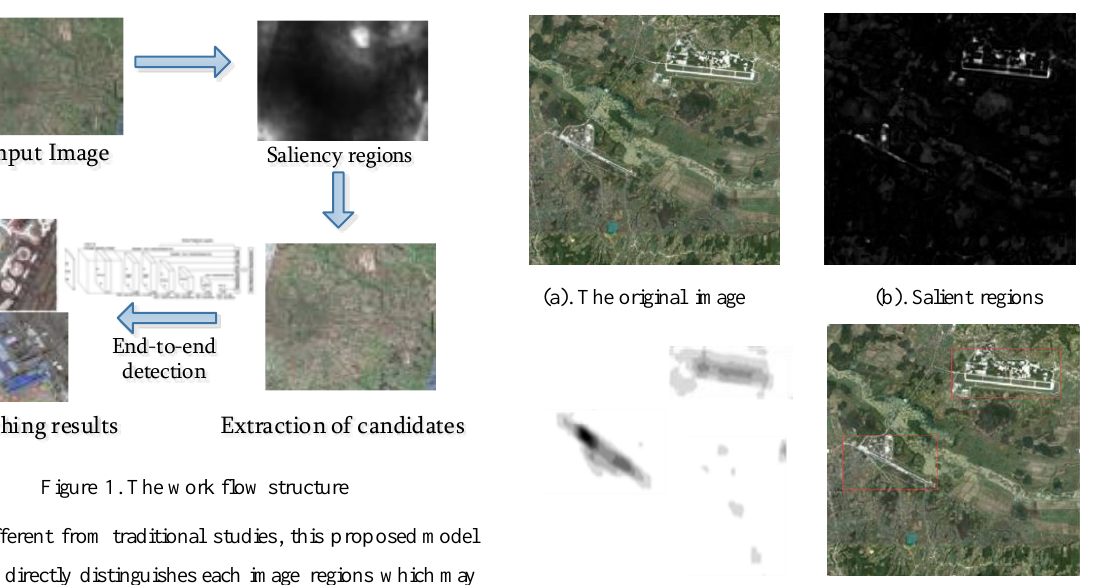
Figure 2. Airplane candidate regions